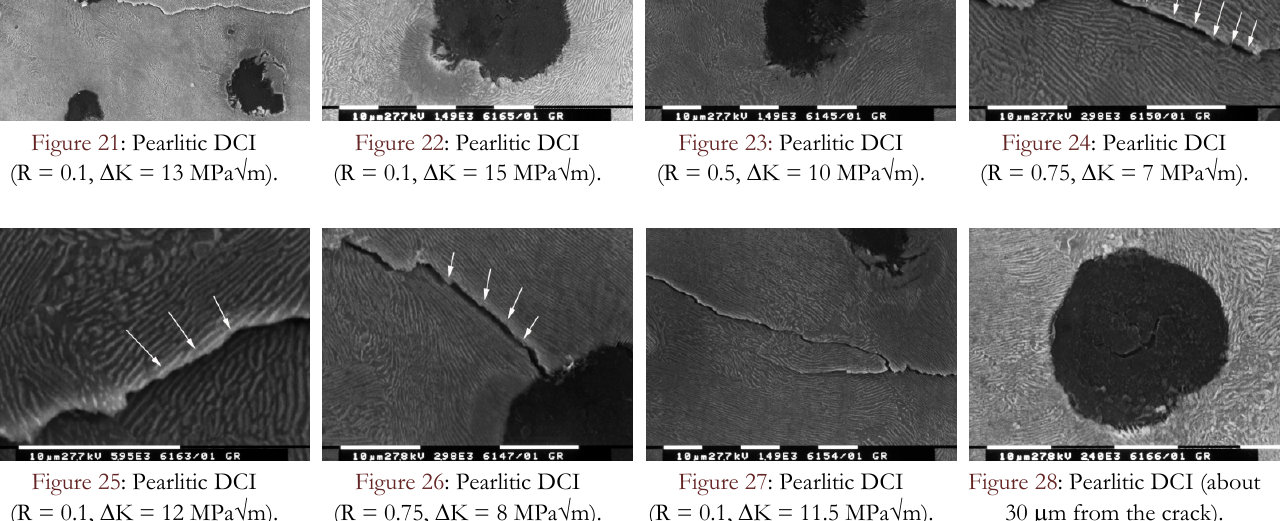
Figure 26: Pearlitic DCI (R = 0.75,  K = 8 MPa √ m).